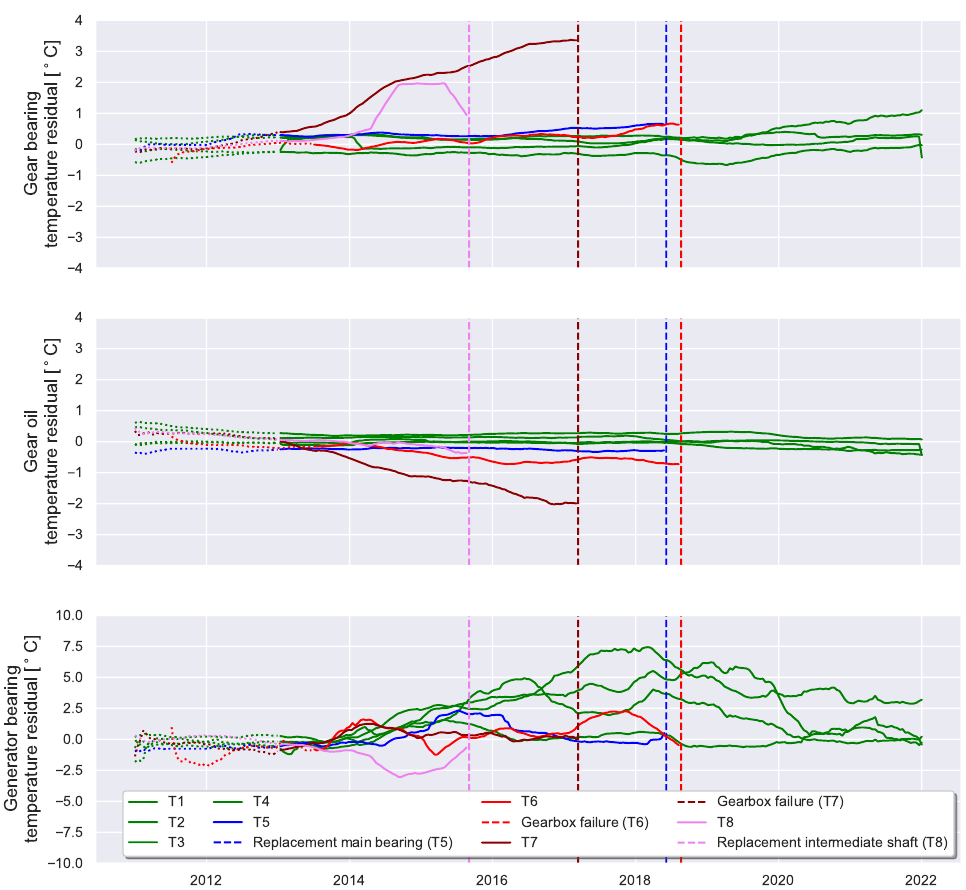
Figure 8. Trend evolution of the residuals for the gear bearing temperature (top), gear oil temperature (middle), and generator bearing temperature (bottom) for the eight investigated turbines. The four turbines without a drivetrain failure are shown in green, and the turbines with failures have distinct colors. The time for each inspected failure is indicated by a vertical line in the corresponding color. The trend during the training period is shown as a dotted line, while the trend in the testing period is shown as a solid